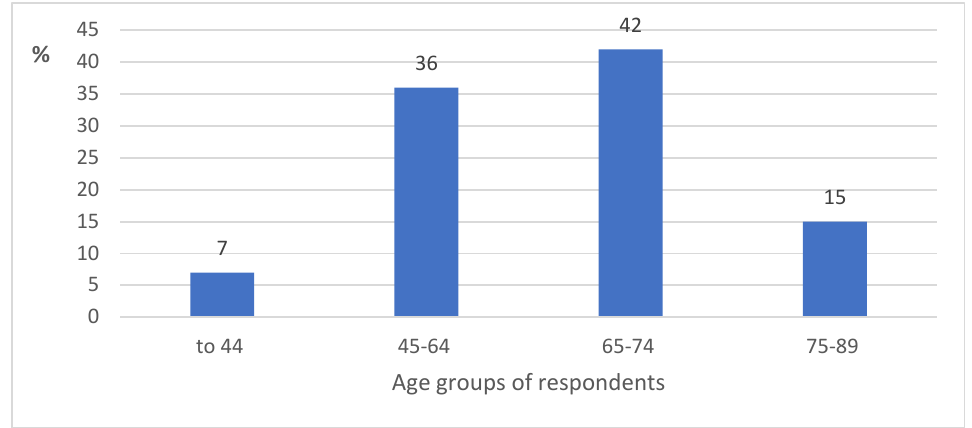
Figure 2 . Percentage distribution of the respondents (N = 74) by their age groups. Figure 2. Percentage distribution of the respondents (N = 74) by their age